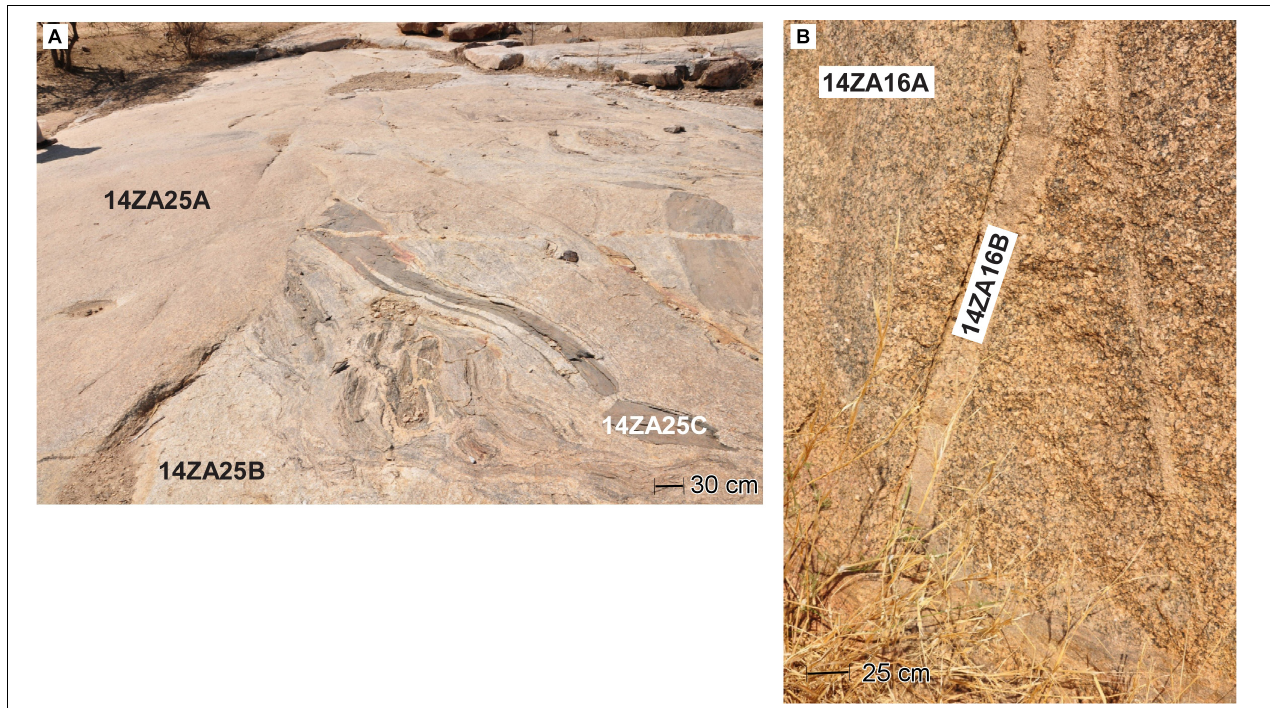
FIGURE 3 | Field photographs of the (A) magnesian collision-related granites near Mongo and the (B) ferroan collision-related granite near El Hidjer.